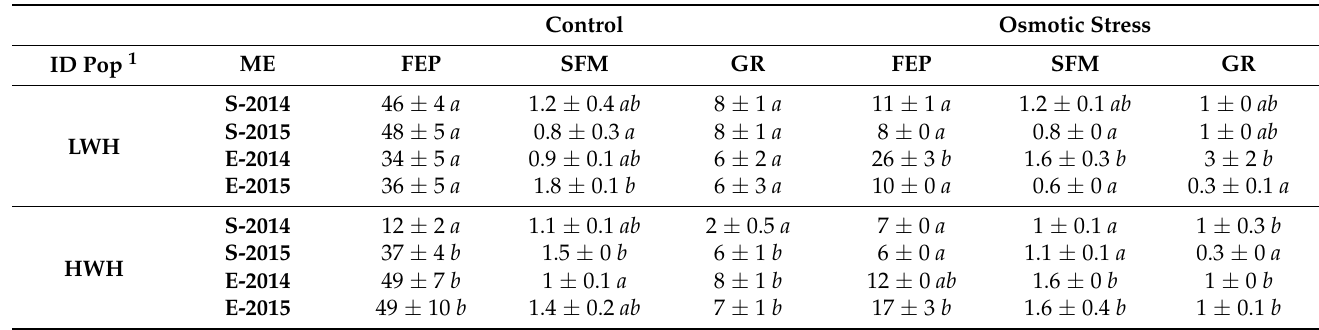
Table 2. Cont. Control Osmotic Stress